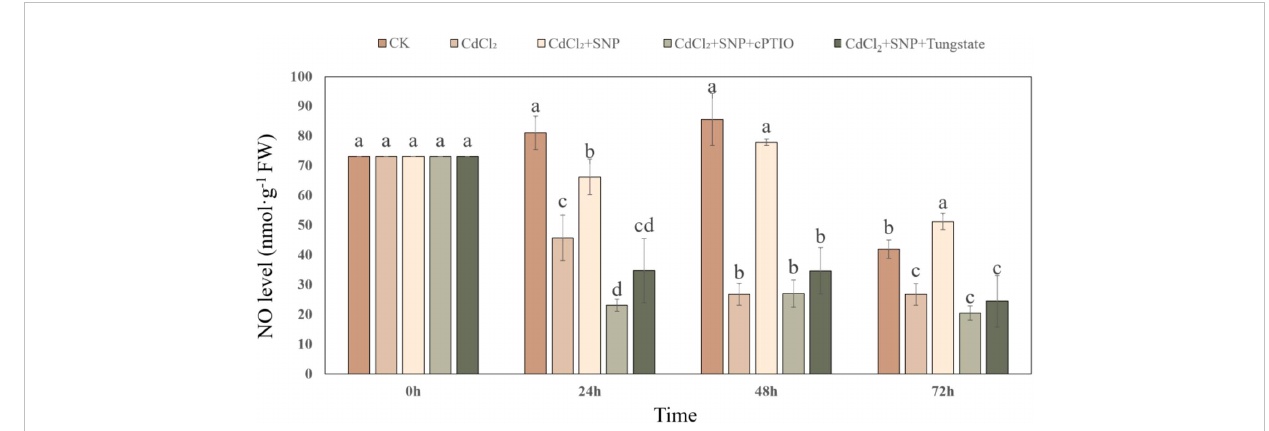
FIGURE 3 Changes in the endogenous NO level during NO-induced adventitious root formation under Cd stress. The primary roots were removed from 5- day-old seedlings. Explants were then incubated for 72 h with distilled water (CK) or 1 m M CdCl 2 , 1 m M CdCl 2 +10 m M SNP, 1 m M CdCl 2 + 10 m M